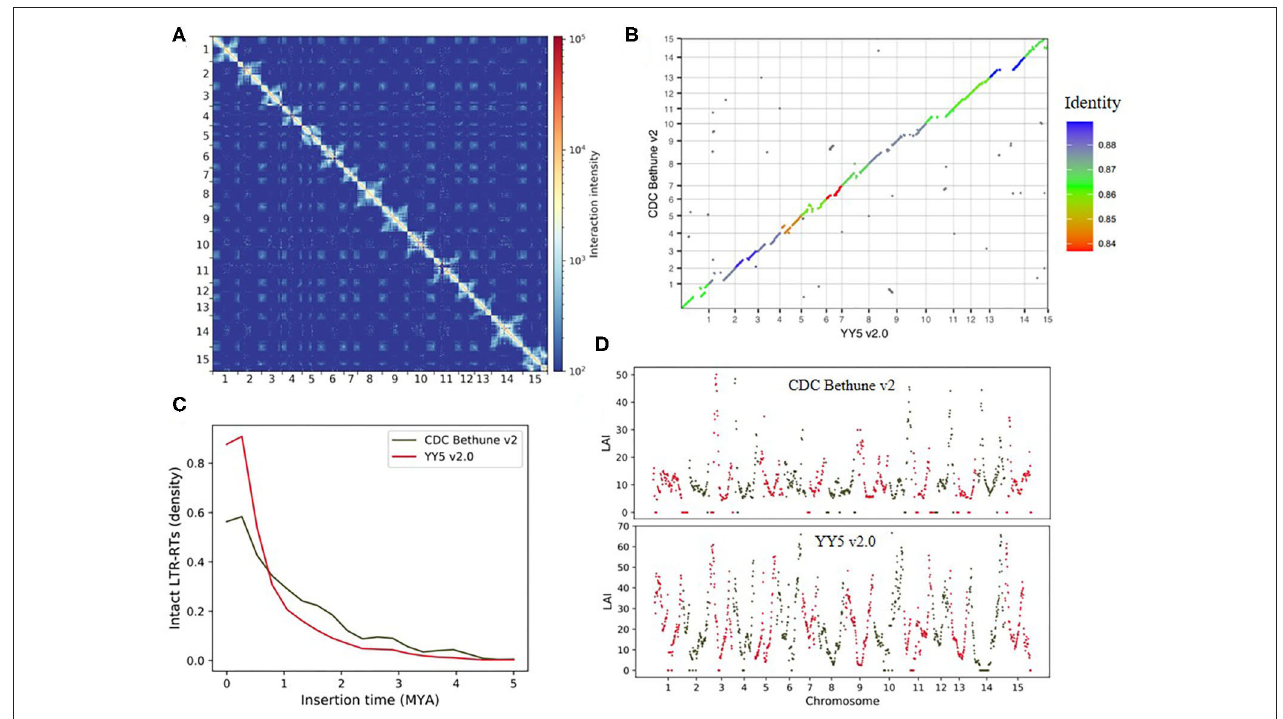
FIGURE 1 | Genome-wide Hi-C interaction heatmaps at 500Kb windows for the YY5 v2.0 genome assembly (A) . Genomic synteny map between the YY5 v2.0 genome assembly and the CDC Bethune v2 genome assembly (B) . Estima ted times of insertion for intact LTR-RTs ( < = 5 MYA) of the YYS v2.0 assembly and the